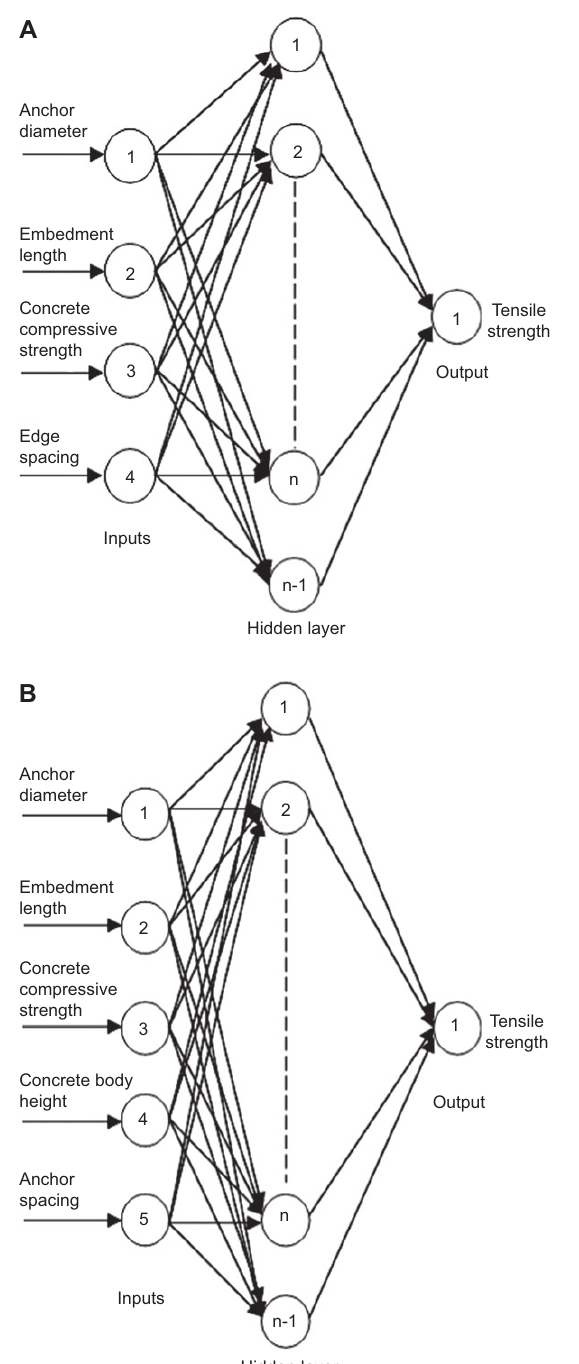
Figure 5 Feed forward multilayer network consisting of an input layer, a hidden layer, and an output layer. (A) Single anchors network. (B) Group anchors network.